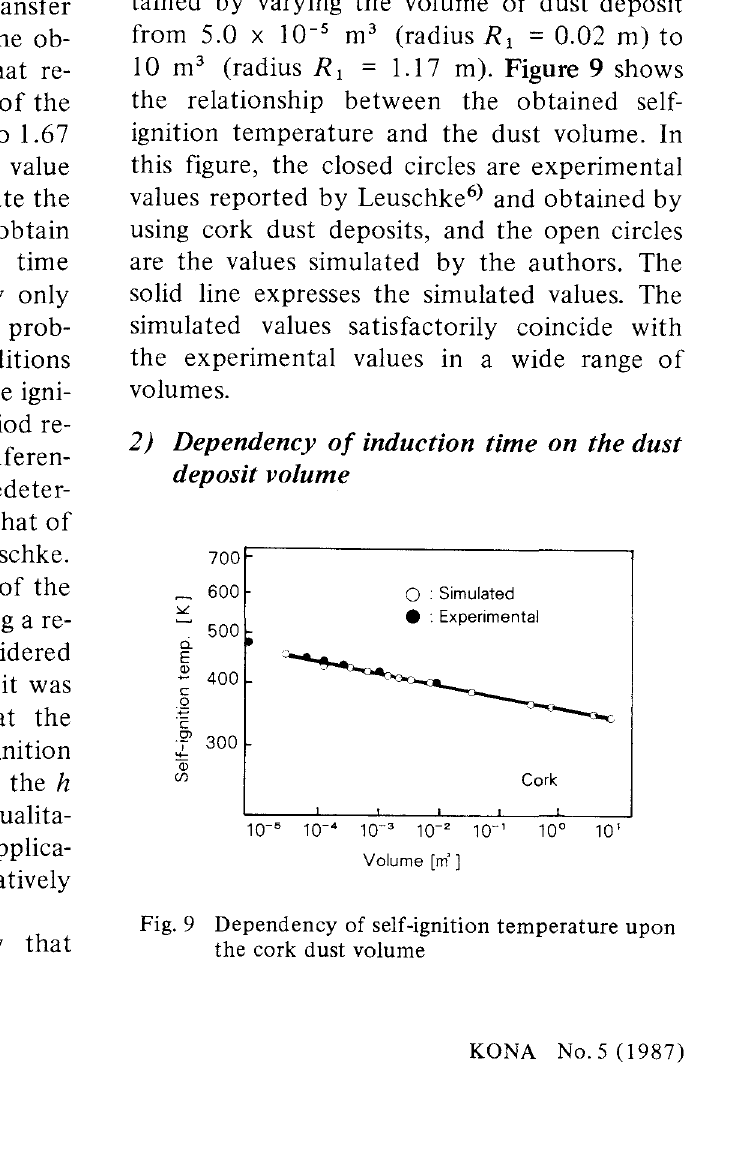
Fig. 9 Dependency of self-ignition temperature upon the cork dust volume